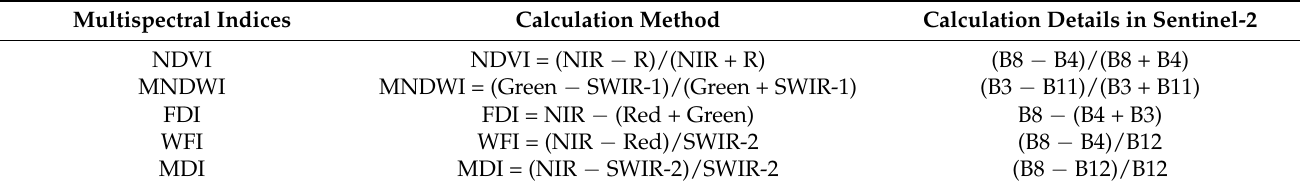
Table 2. Calculation method of multispectral indices.